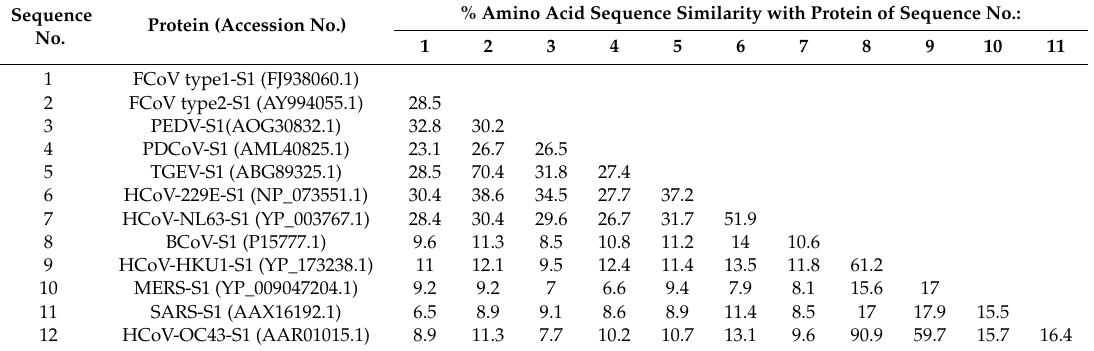
Table 2. Percentage identity matrix of every pair of sequences of spike S1 subunit. Sequence